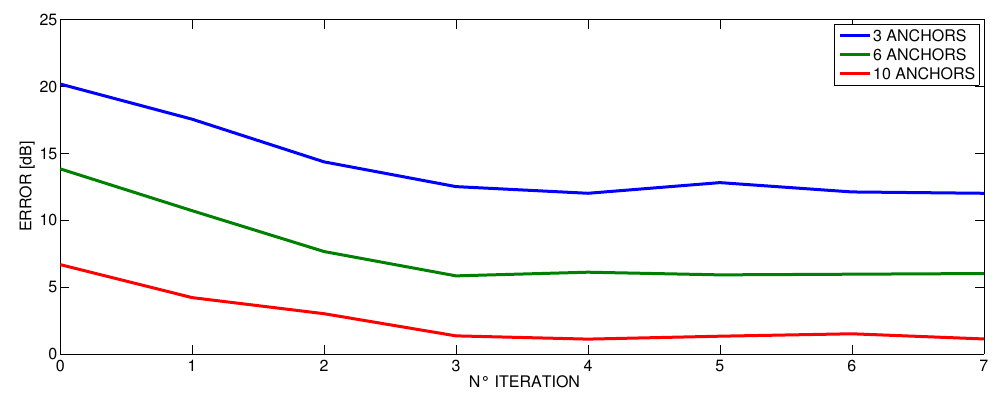
Figure 16. Decrease of error by method iteration in the